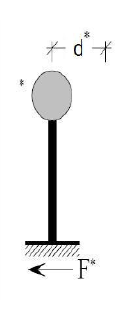
Fig. 9. Equivalent SDOF system.